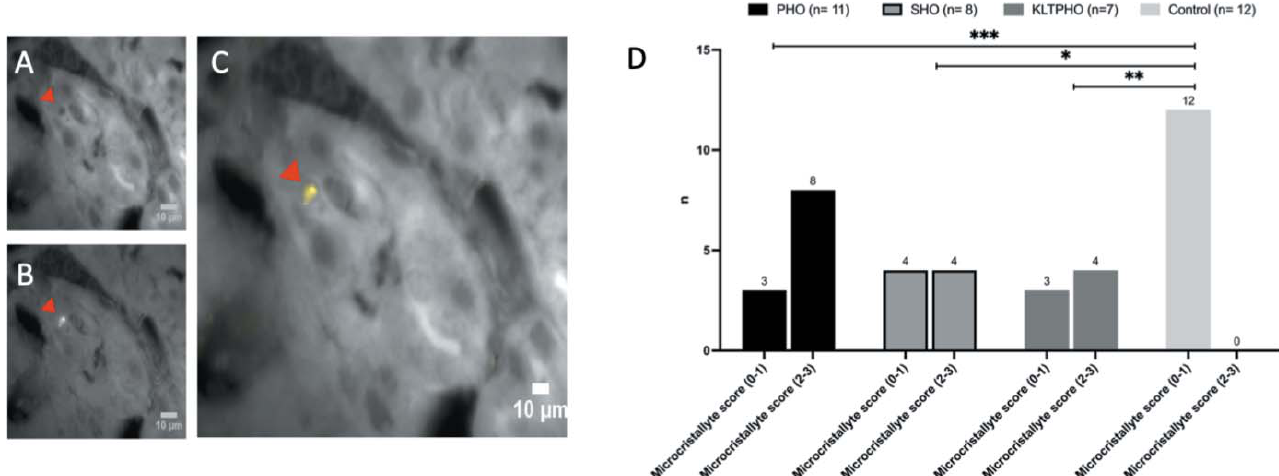
Figure 4 Synchrotron WFUV allows detection of CaOx microcrystallites in kidney biopsies. The bright spot in the 412–438 nm channel (A), indicated by the arrowhead, corresponds to a focal shadow in the 327–353 nm channel (B) resulting in a strong yellow spot after signal subtraction (C). (D) Frequency of the semi-quantitative microcrystal score [0: no crystal; 1: scarce crystals (<3 per map); 2: few crystals (3–10 per map); 3: numerous microcrystals (>10 per map)] in PHO, SHO and KLTPHO and control biopsies. *** p < 0.001; ** p < 0.01; * p < 0.1.